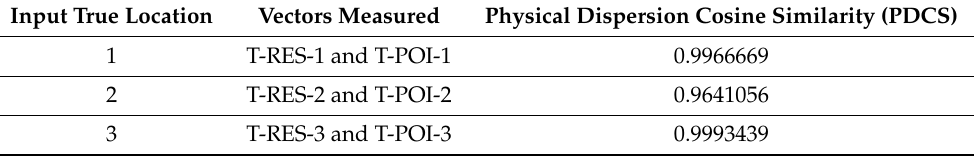
Table 5. Cosine similarity is measured between residential and POI semantic categories for the three input true